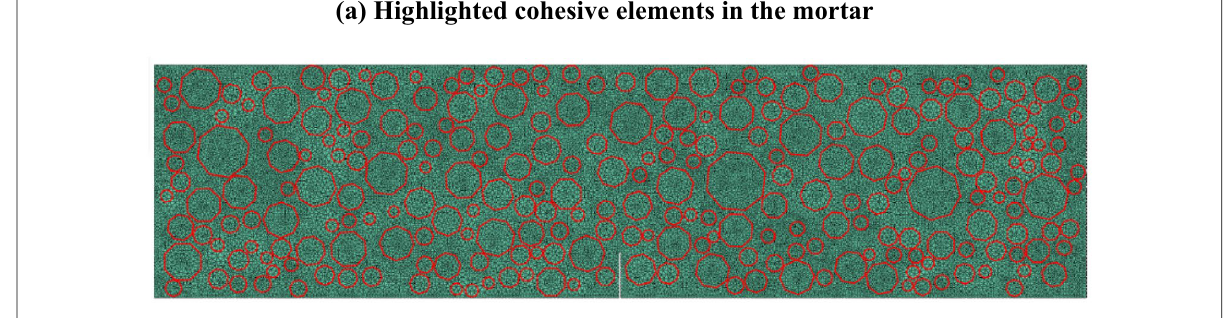
(b) Highlighted cohesive elements in the ITZ Fig. 8 Finite-element grid model of concrete three-point bending beam with the cohesive elements